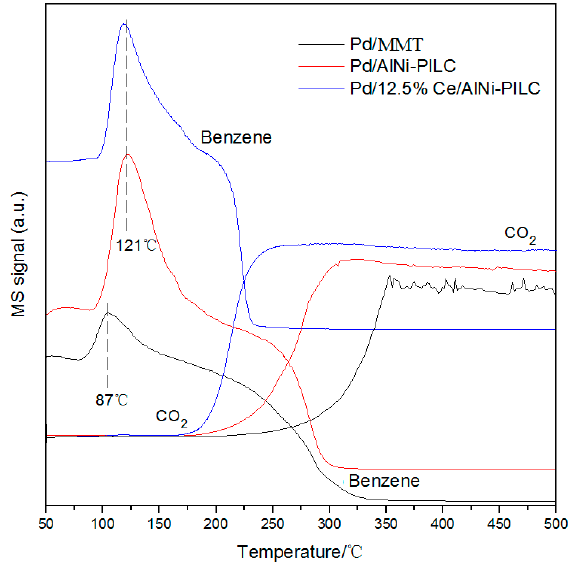
Figure 8. Results of benzene-TPSR characterization for benzene combustion over the catalysts.